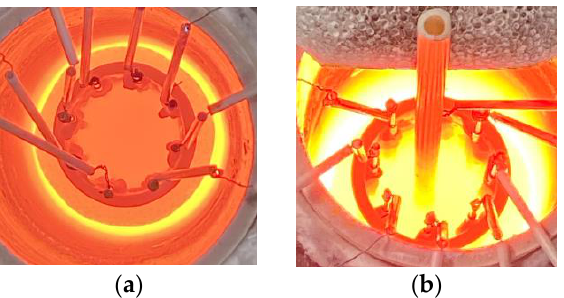
Figure 7. Measurements of the spatial and temporal distribution of oxide crystal φ at 1000 ° C in the crucible furnace mimicked by ( a ) liquid phase of 60ZnO-40B 2 O 3 as a background and ( b ) with a ∅ 8 mm Al 2 O 3 rod as an inclusion.